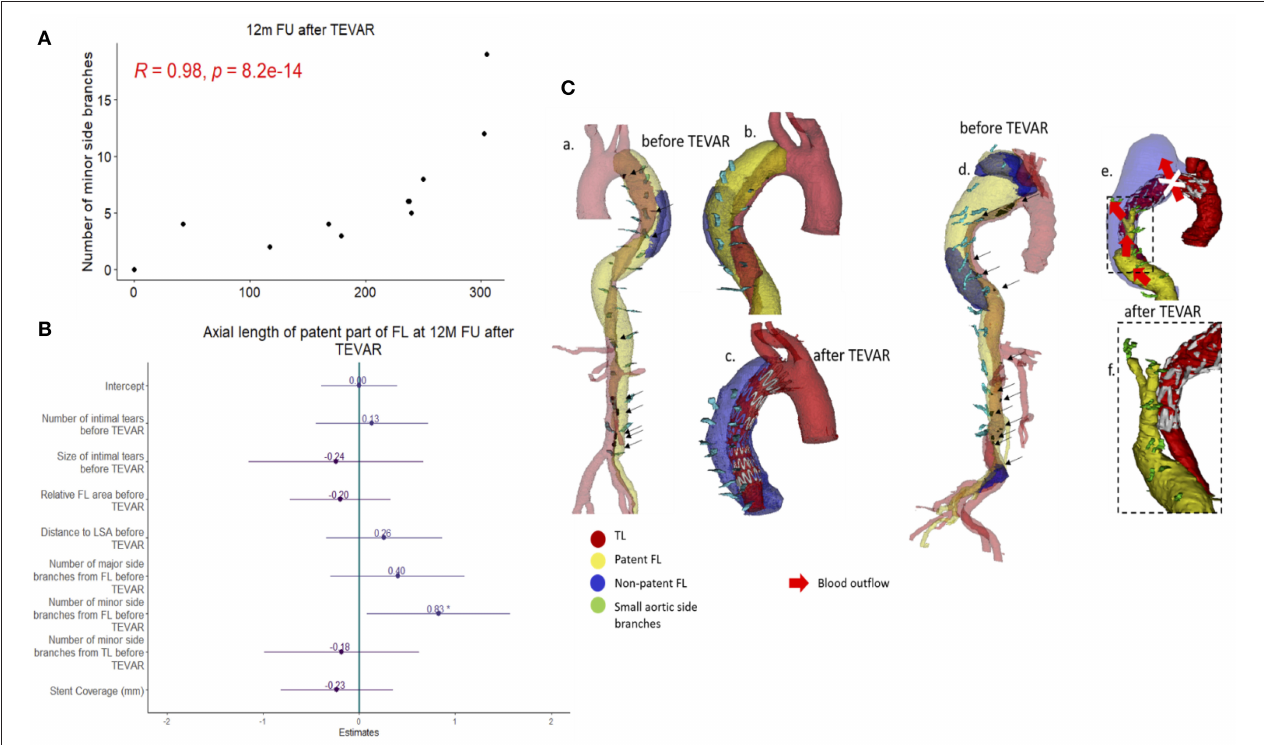
FIGURE 5 | Correlation between the patent false lumen (FL) length and the number of minor side branches arising from the FL (A) Spearman’s rank correlation was applied and the corresponding p -value is displayed. Forest-plot of standardized beta values for a multiple linear regression model for the axial length of the patent FL at 12 months follow-up for patients receiving thoracic endovascular repair (TEVAR) (B) . Two cases of aortic remodeling following TEVAR (C) . For the case on the left, the FL is partially patent prior to TEVAR (a,b) and non-patent following TEVAR (c). For the case on the right, the FL is partially patent both prior to (d) and following (e,f) TEVAR. Note that partial retrograde patency of the FL occurs which sustains blood flow to minor side branches arising from the FL prior to